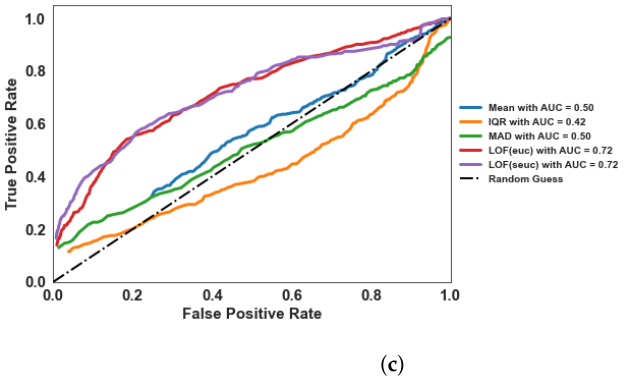
Figure 4. Robustness of LOF algorithm compared to the mean and the median-based (namely, Interquartile Range (IQR) and Median Absolute Deviation (MAD)) techniques in detecting bad channels in ( a ) newborn, ( b ) infant, and ( c ) adult data. For comparison within LOF, we used the default Euclidean distance metric ( euc ) and the Standardized Euclidean metric ( seuc ). LOF ( seuc ) performs better than LOF ( euc ) and the considered statistical measures.